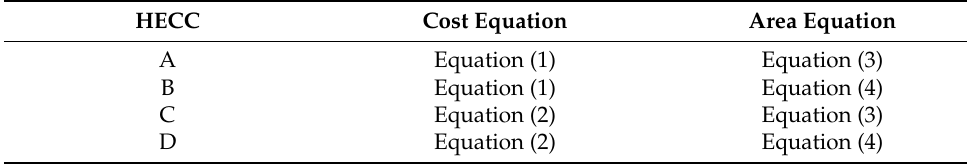
Table 1. Four HECCs of